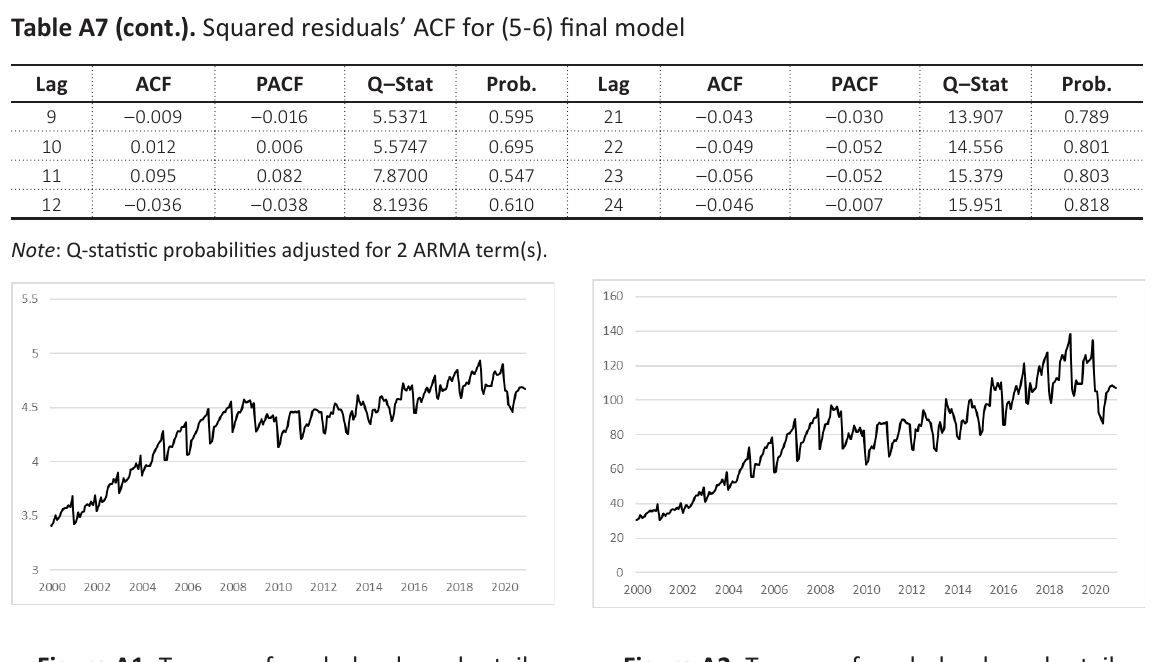
Figure A2. Turnover for wholesale and retail trade and repair of motor vehicles and motorcycles in Bulgaria (logs)